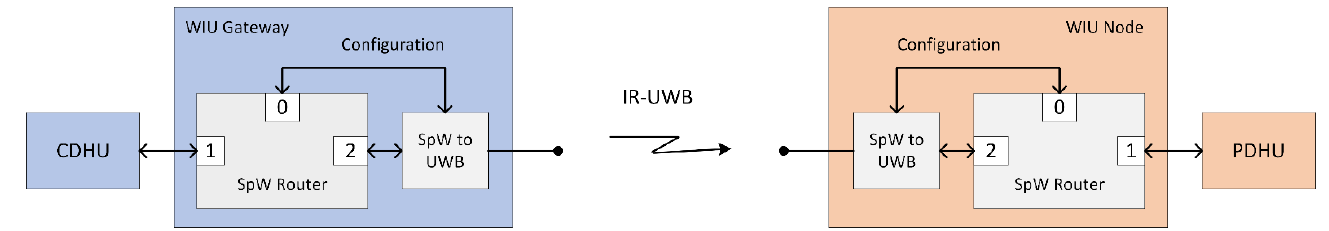
Figure 1. System architecture: wired-to-wireless requirements (the numbers indicated on the SpW Router (i.e., 0, 1, and 2) represent the port number of the SpW Routers).